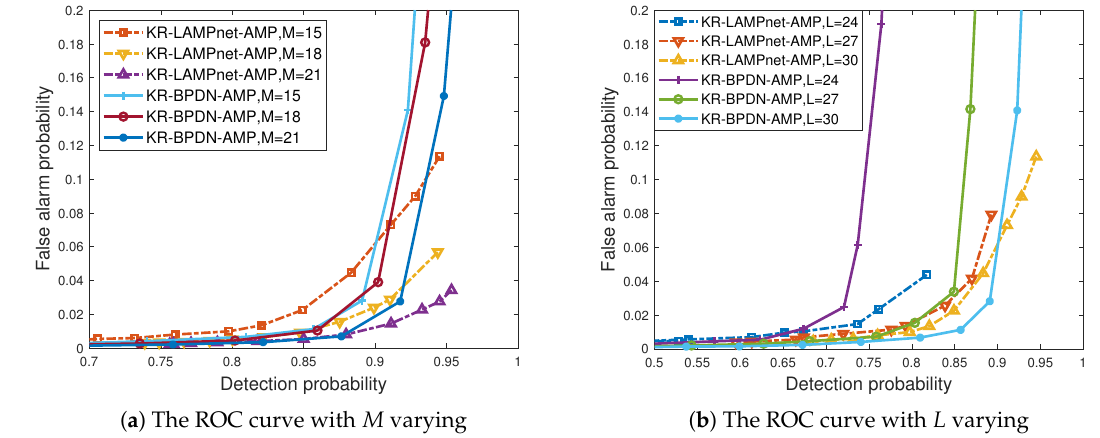
Figure 5. Comparision of KR-LAMPnet-AMP and KR-BPDN-AMP.